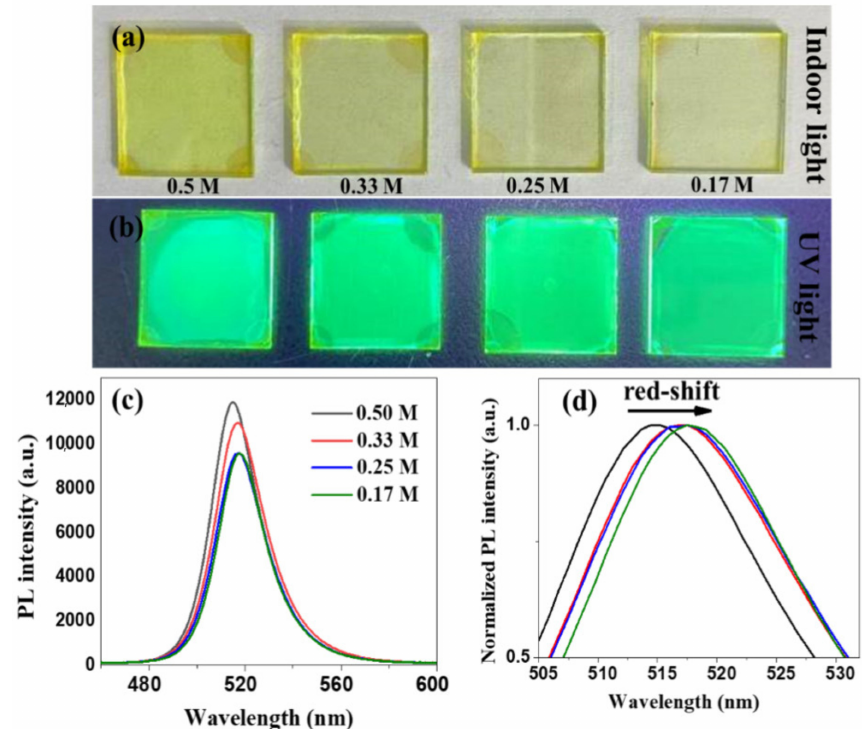
Figure 1. Optical pictures of the films formed by different concentrations of perovskite precursor solutions: ( a ) Indoor lamp irradiation. ( b ) UV lamp irradiation. PL curves of films prepared with different solvent dosages of perovskite precursor solution: ( c ) PL intensity curves. ( d ) Normalized PL intensity curves, plotted as PL spectra in the range of 505 to 530